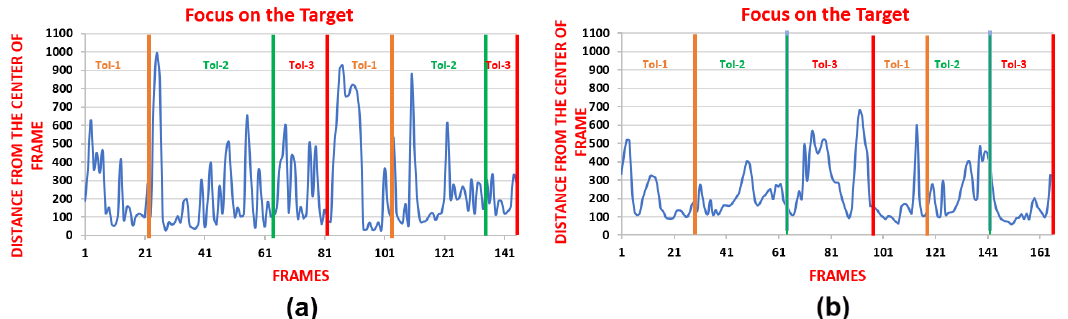
Figure 10. Experiment 2 focus precision (pixels) for variation 2 ( a ) RC, ( b ) GazeGuide.